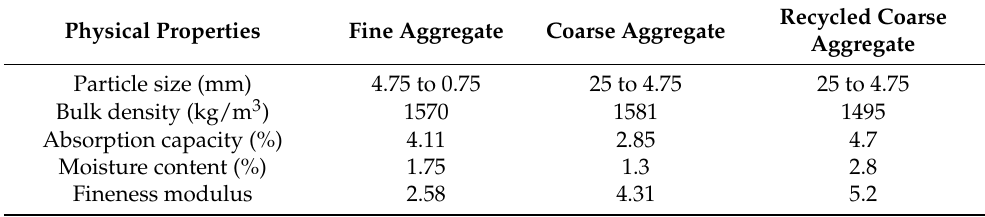
Table 3. Physical Properties of Fine and Coarse Aggregates.